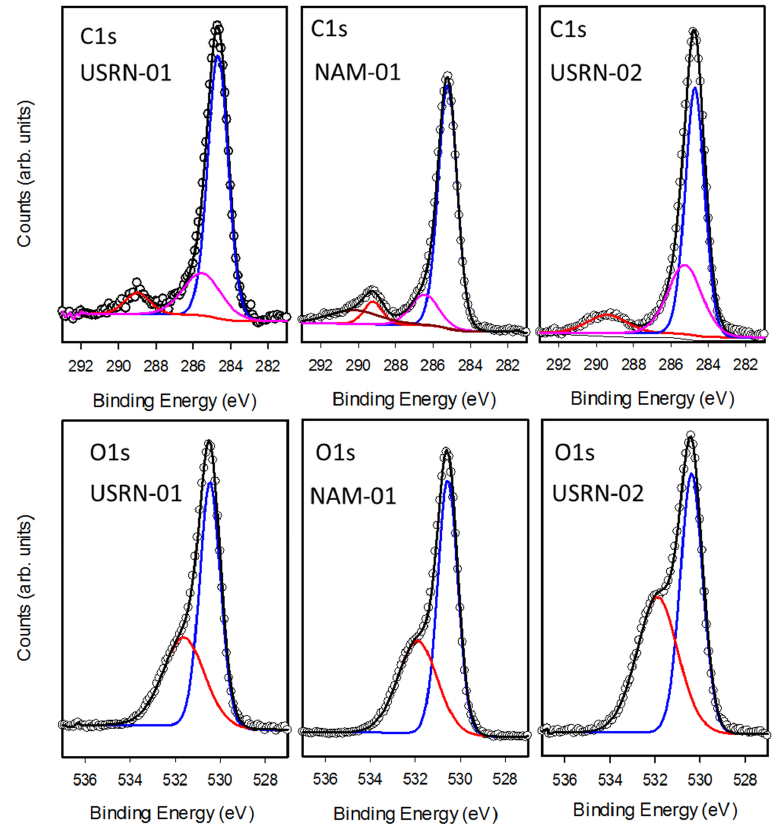
Figure 6. XPS spectra of the C1s (top) and O1s regions for 3 of the unmodified ZnO samples. The spectra are fit with a Shirley background and mixed Gaussian-Lorentzian peaks (GL30) using CASA-XPS software. The variously colored peaks correspond to the components in Table 3; C1s blue (C1), pink (C2), red (C3) and dark red (C4), O1s blue (O2) and red (O3).